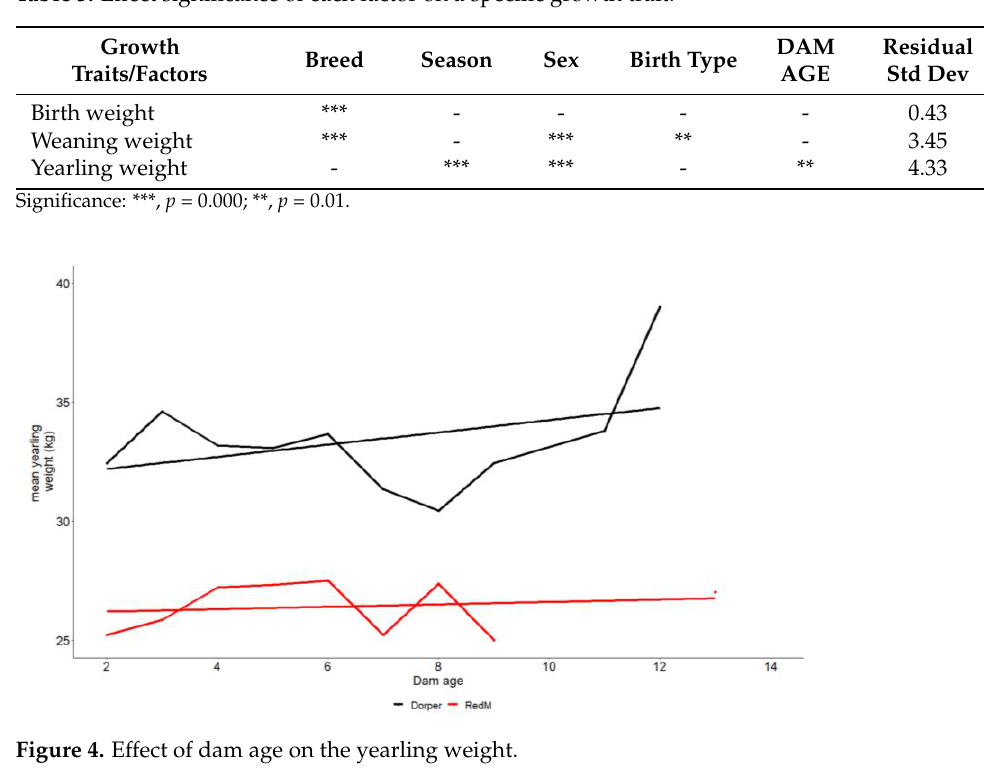
Table 3. Effect significance of each factor on a specific growth trait.